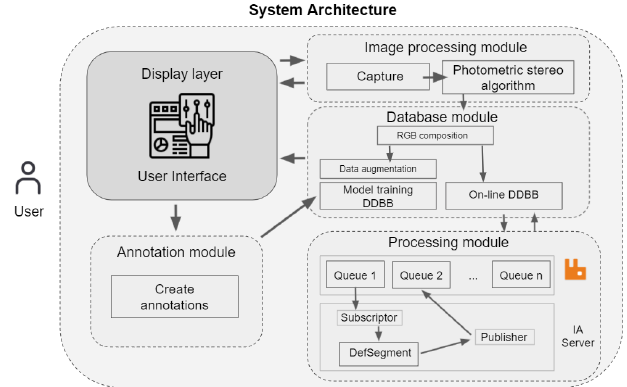
Figure 5. System architecture for defect detection in steel components.